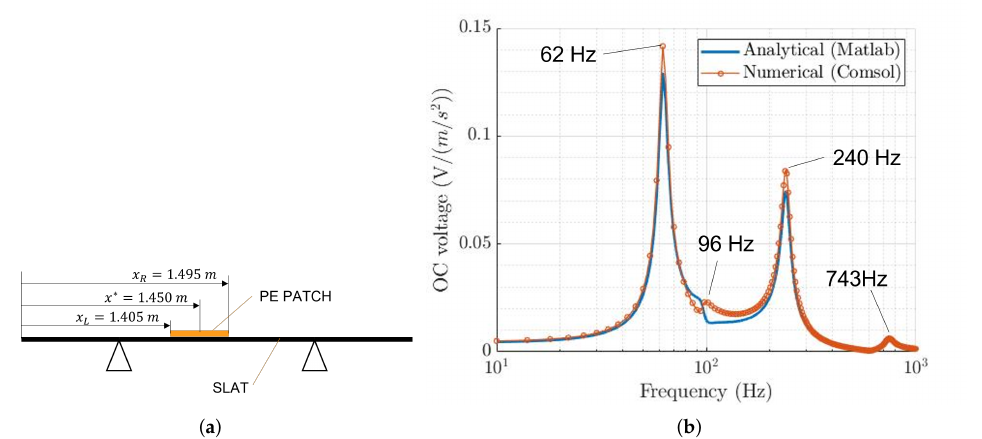
Figure 13. ( a ) Location of the considered PE patch; ( b ) comparison between the analytical and numerical